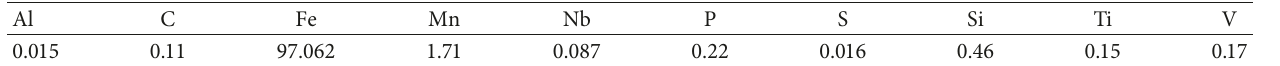
Figure 2: The instruments used for the analysis of the chemical composition of the weld bead. (a) FLS980-stm Edinburgh fluorescence spectrometer. (b) Metallographic microscope. (c) The cross section of the weld bead. Table 2: Chemical compositions of the weld bead (wt.%).